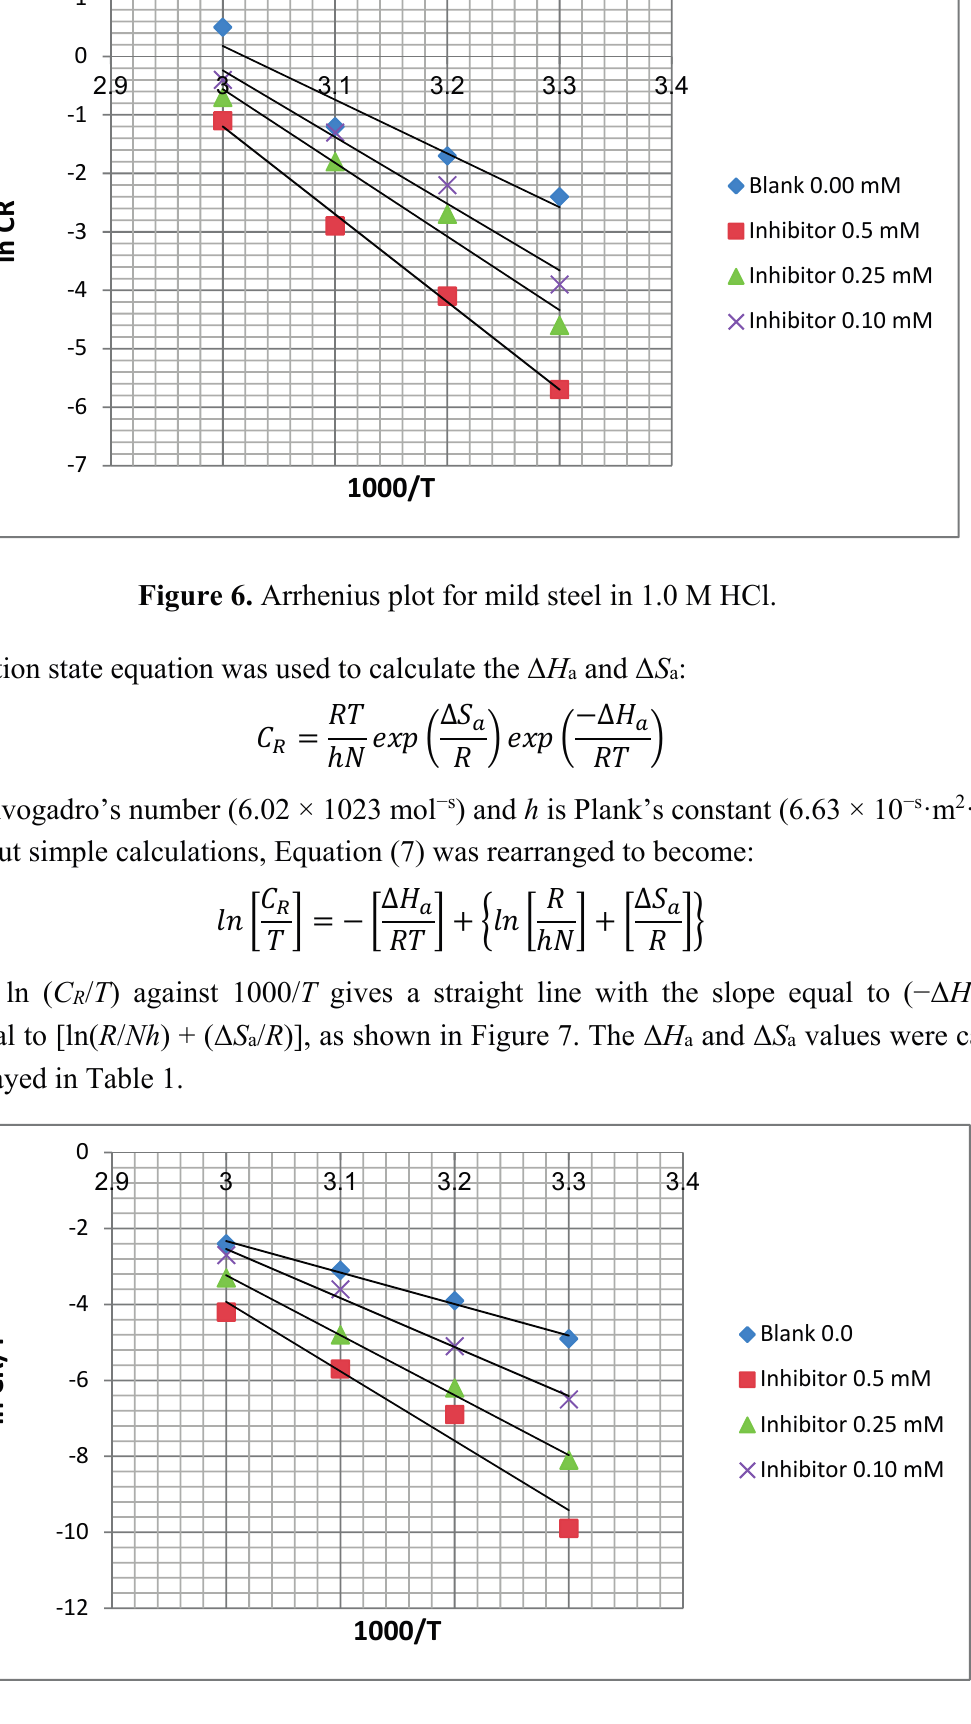
Figure 7. Transition state plots for mild steel in 1.0 M